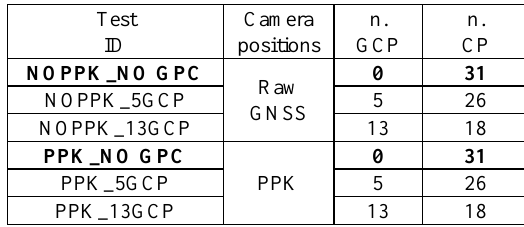
Table 1. Summary of the adopted photogrammetric processing configurations. Direct georeferencing approaches highlighted in